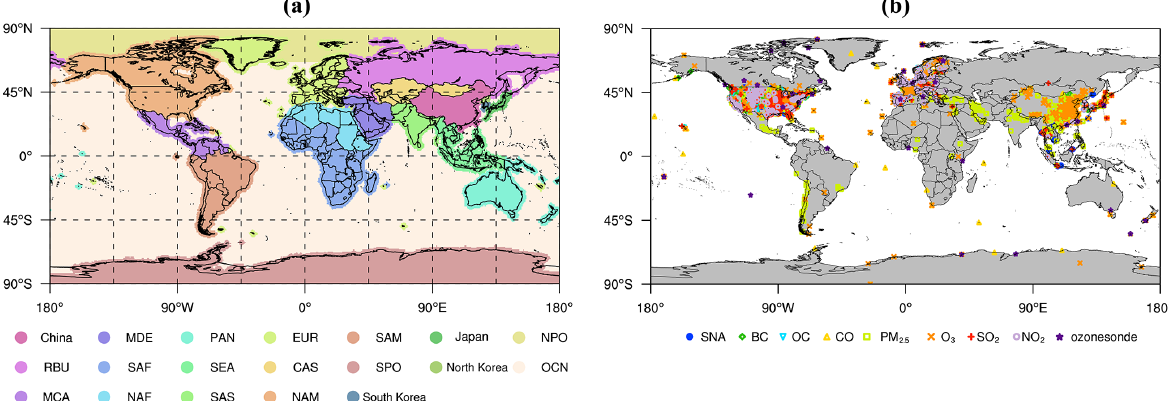
Figure 1. (a) Model domain and (b) stations for the evaluation used in this study. Table 1. Total emissions from several regions used in the GNAQPMS simulation